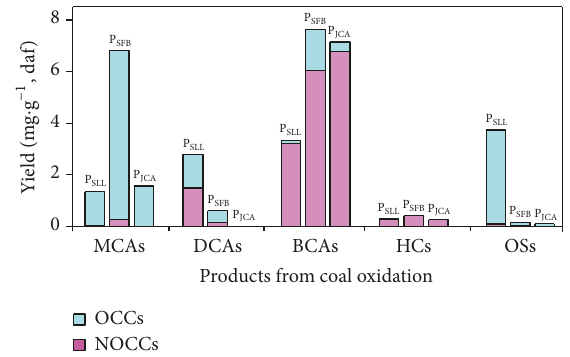
Figure 2: Distribution of products from coal